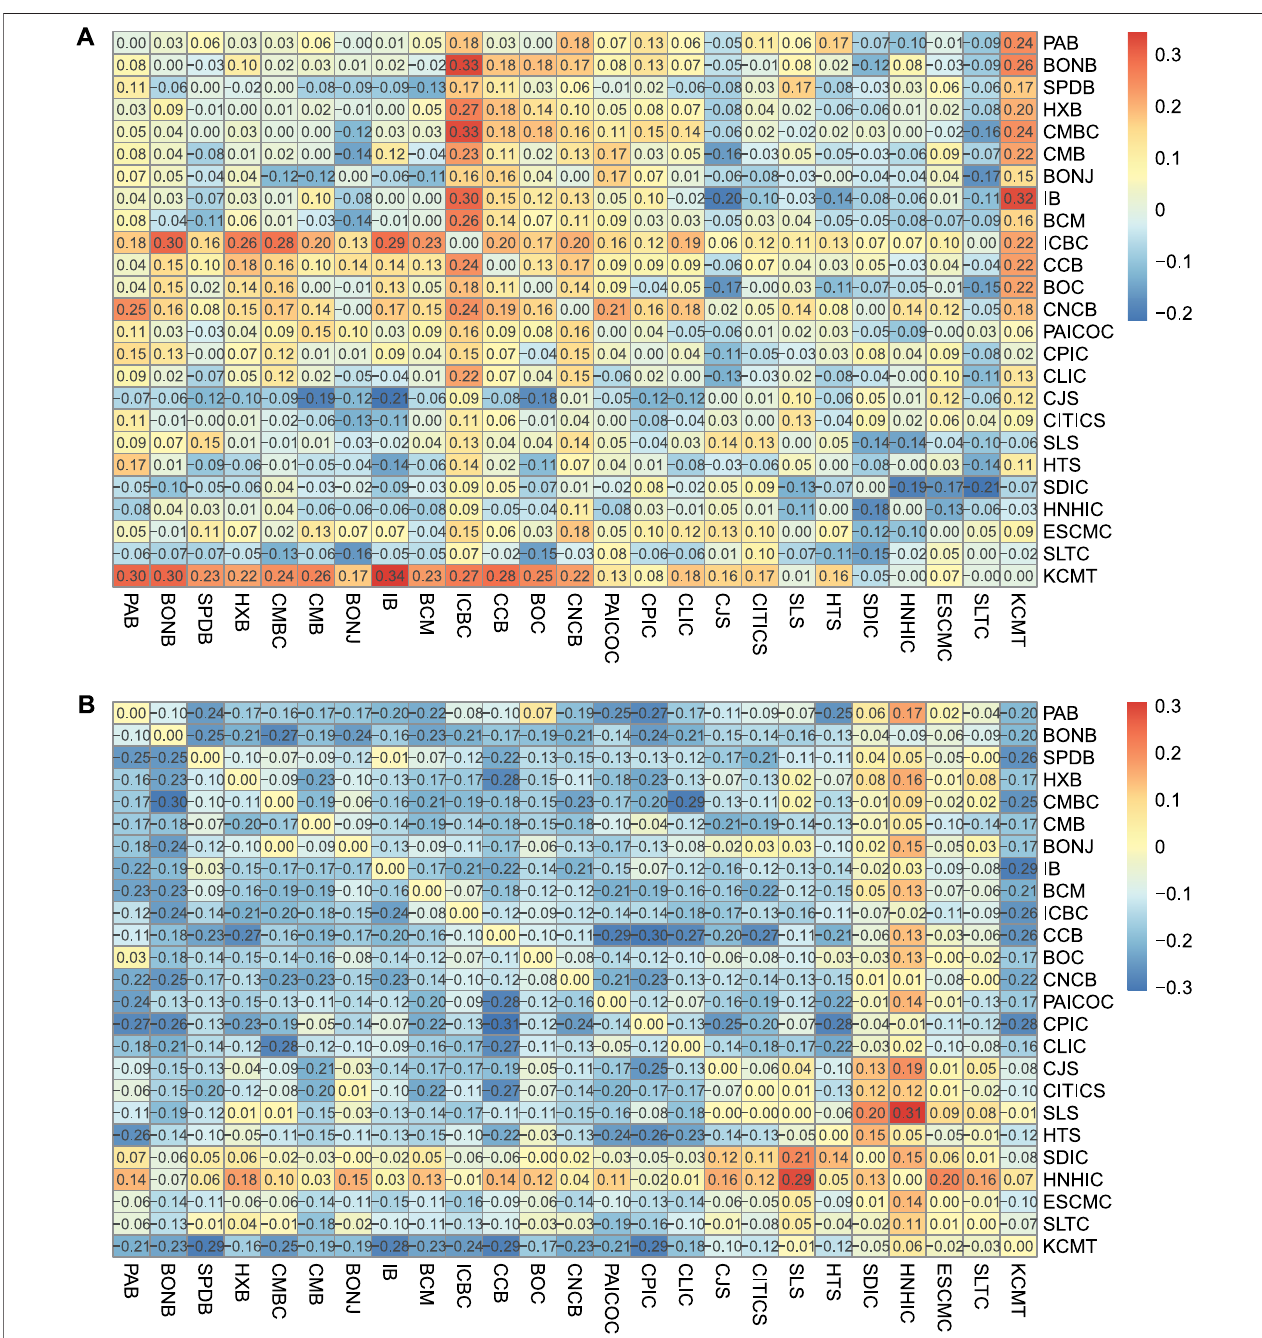
FIGURE 2 | Systemic linkage variation table for the Chinese SIFIs. (A) Systemic linkage variation table from stage 1 to stage 2. (B) Systemic linkage variation table from stage 2 to stage 3.